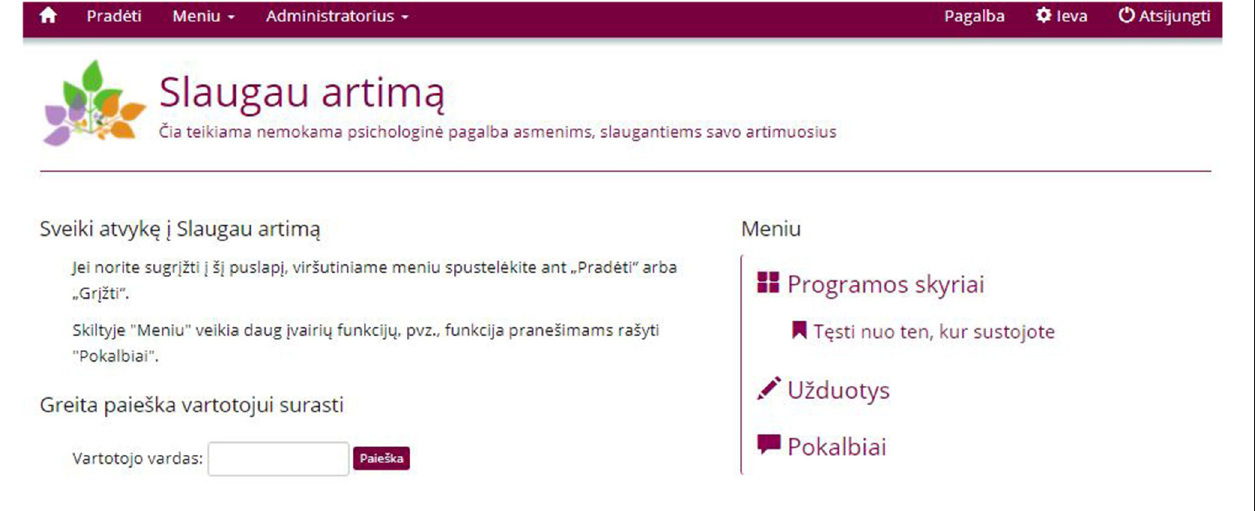
Frontiers in Medicine |